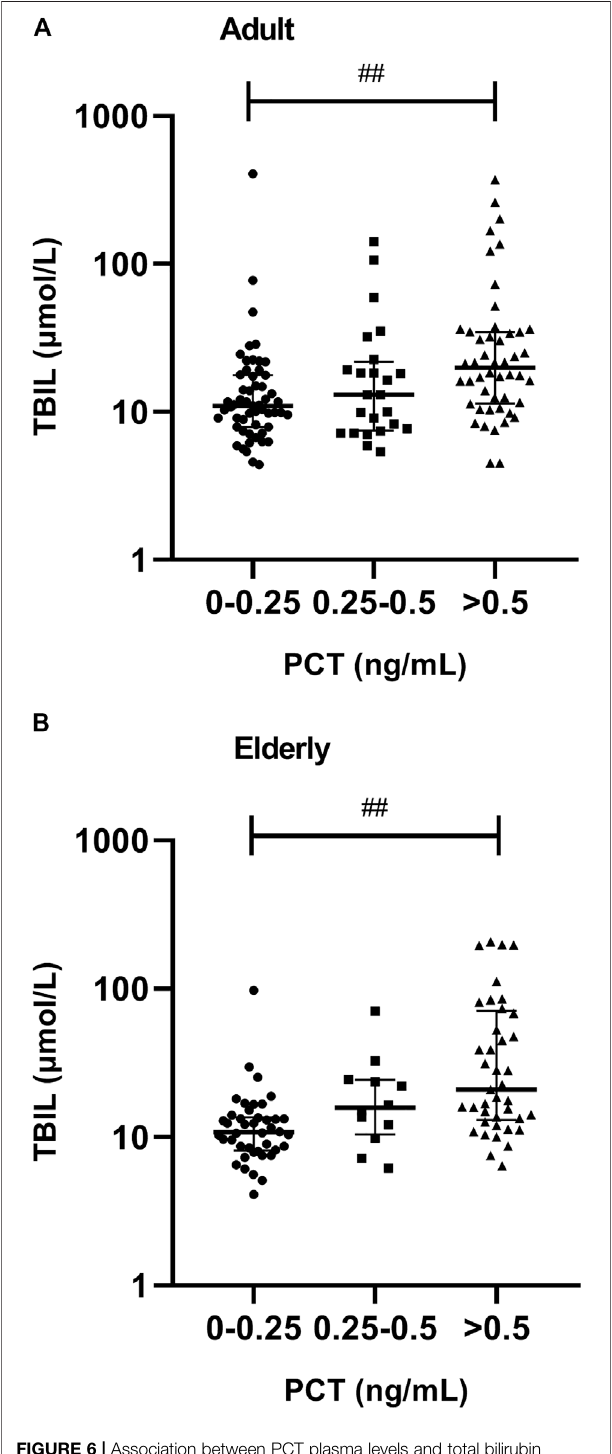
FIGURE 6 | Association between PCT plasma levels and total bilirubin (TBIL)inadultandelderlypatients. (A) DistributionofTBILinadultpatients. (B) Distribution of TBIL in elderly patients. ## p <